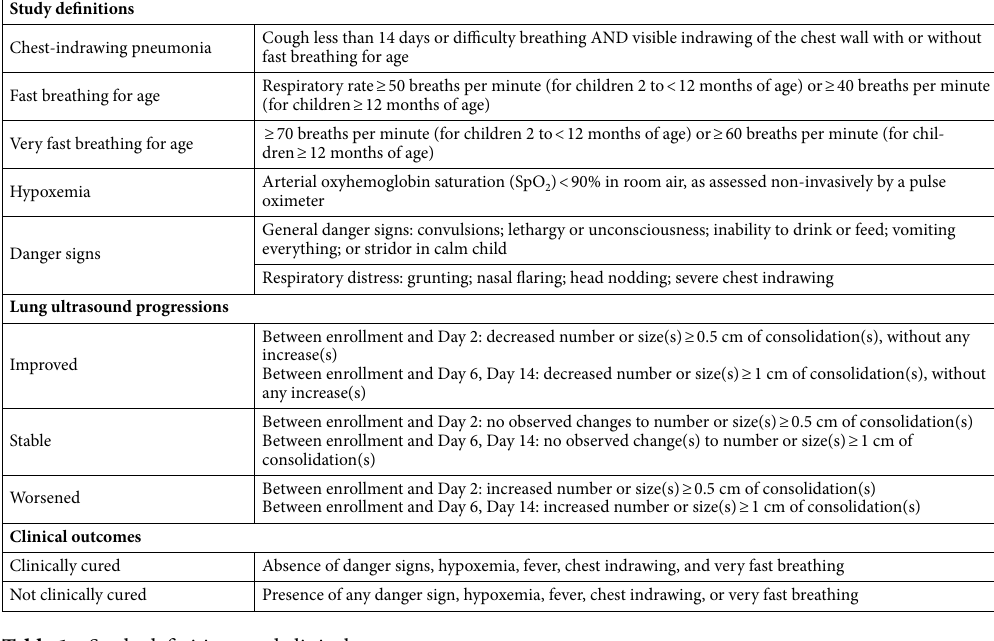
Table 1. Study definitions and clinical